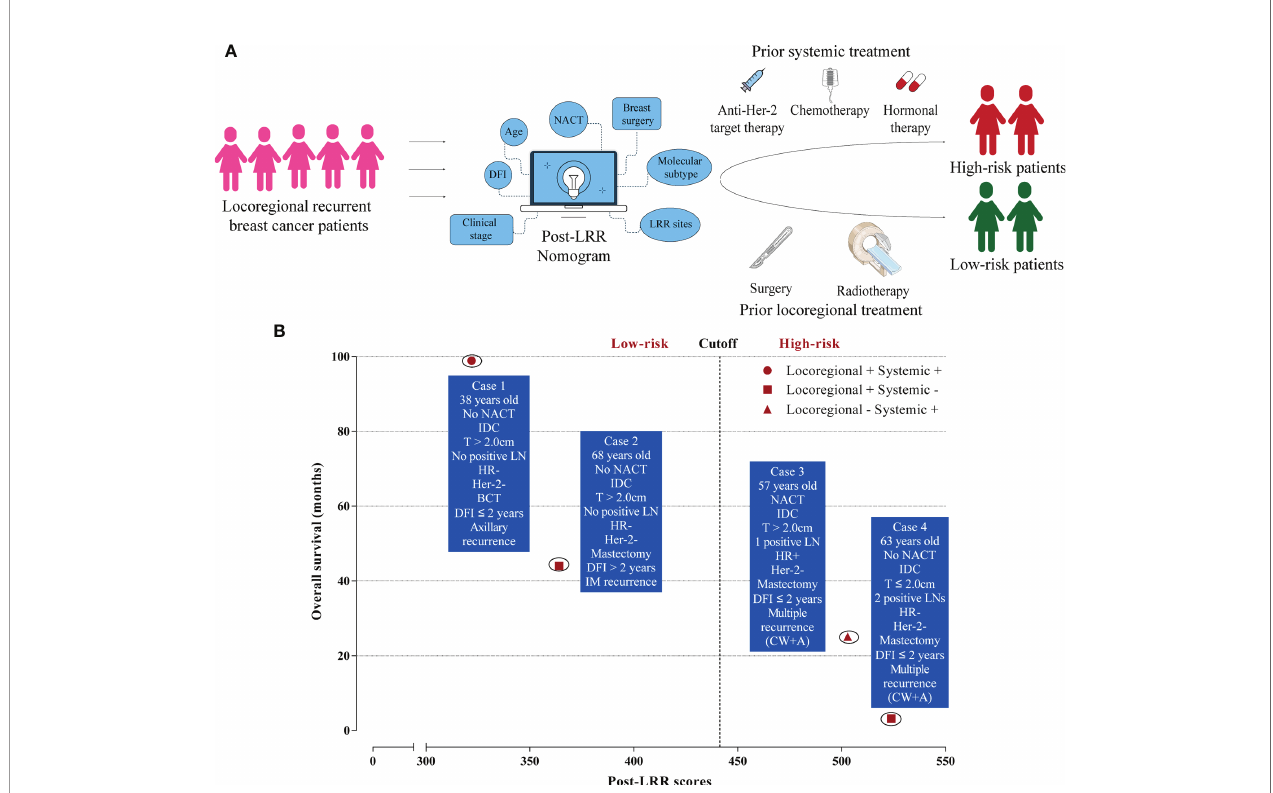
FIGURE 4 | Clinical management of locoregional recurrent breast cancer patients. (A) The schematic diagram of post-locoregional recurrent breast cancer patient management based on the nomogram; (B) Examples of low and high-risk patients in real-world practice. LRR, Locoregional recurrence; DFI, Disease-free interval; NACT, Neoadjuvant chemotherapy; IDC, Invasive ductal carcinoma; LN, Lymph node; HR, Hormonal receptor; BCT, Breast-conserving treatment; IM, Internal mammary; CW, Chest wall; A,